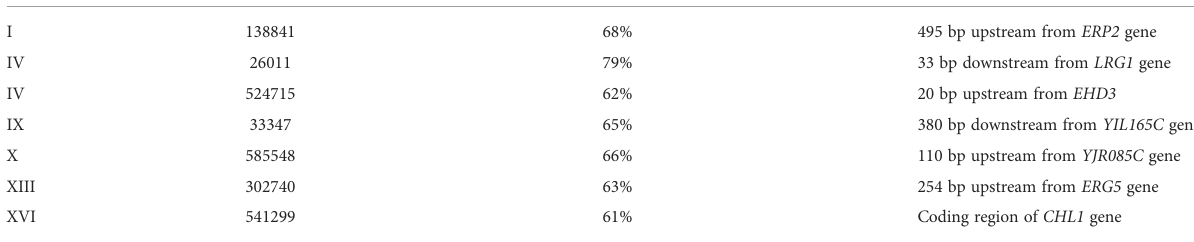
TABLE 1 Details of Ppmar2NA reinsertion sites.